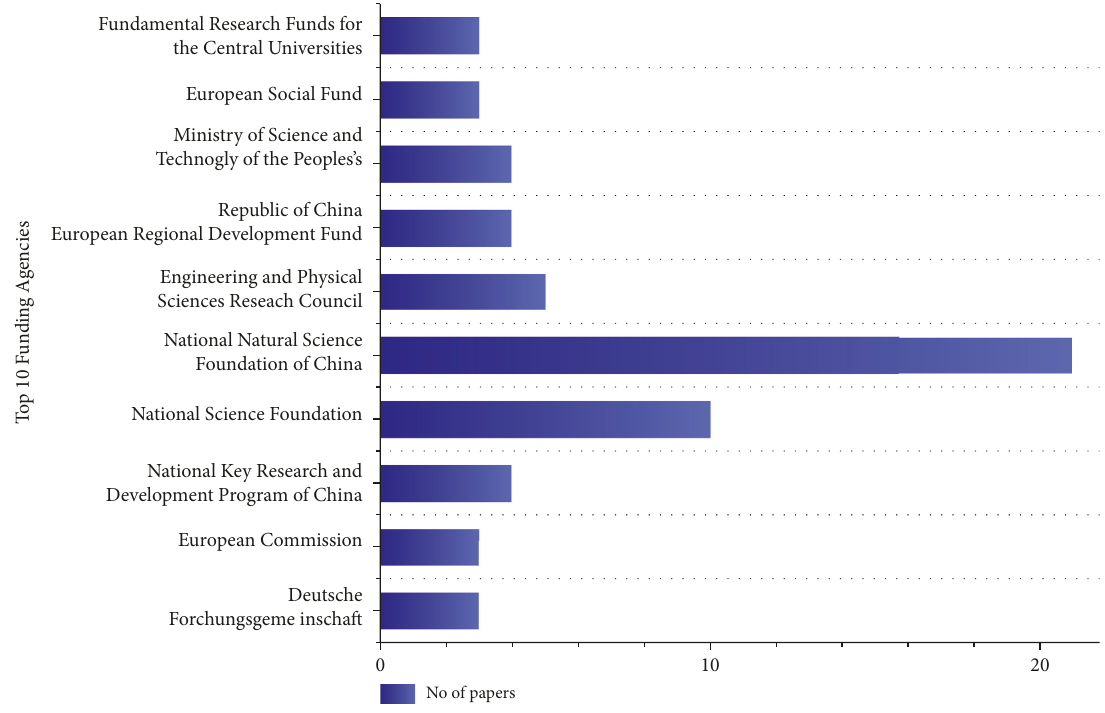
Figure 13: Top 10 funding agencies for 2001 to